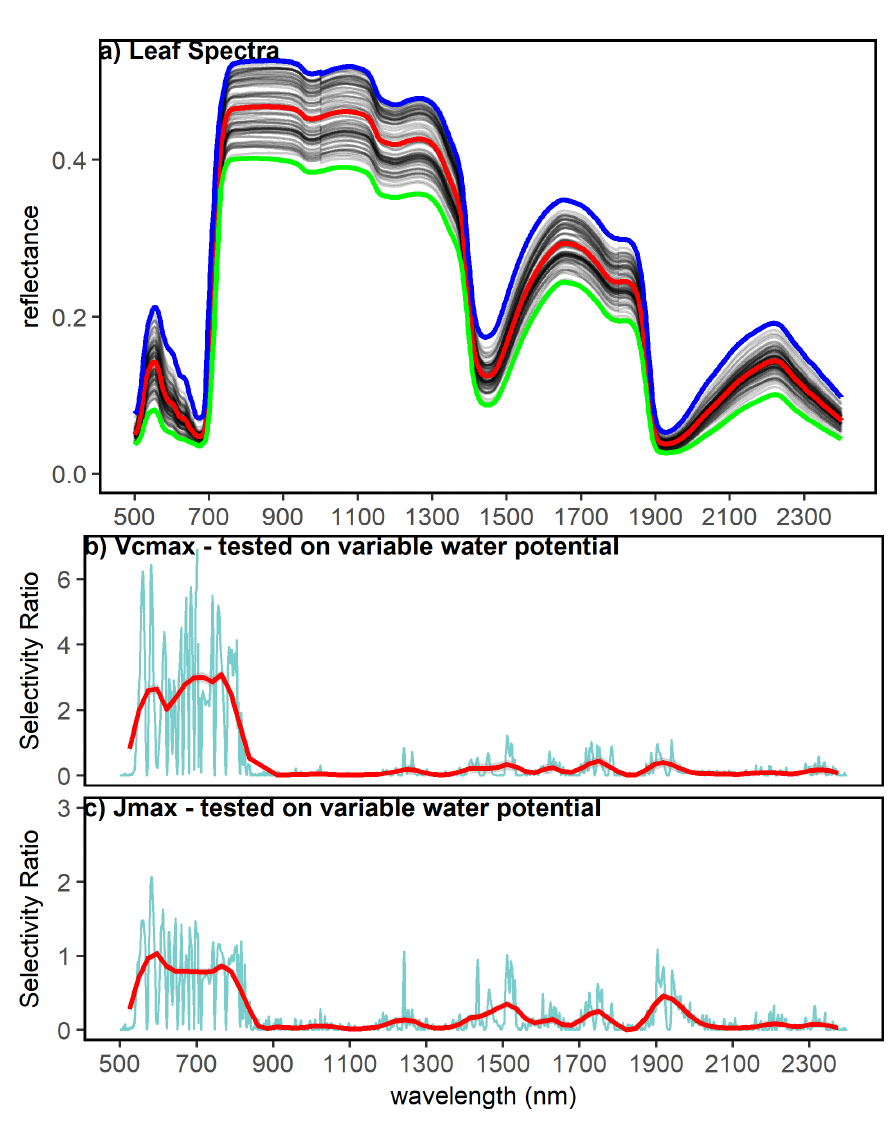
Fig 2. Leaf reflectance spectraand wavelength importance in PLSR models. (A) Pooledreflectance spectra ( λ = 450–2500nm) for all plants studied throughout the course of the study period(5/24/2016to 7/05/ 2017). The mean reflectance at each wavelengthis shown by the red line, the maximum and minimum reflectance at each wavelengthare shown by the blue and green lines, respectively. (B)&(C): selectivity ratio of each wavelengthin the PLSR models tested on variable water potential. (B) Shows the selectivity ratio of each wavelengthin the V cmax PLSR model, and (C) shows the selectivity ratio of each wavelengthin the J max PLSR model. The red lines in B&C are LOESS smoothers for